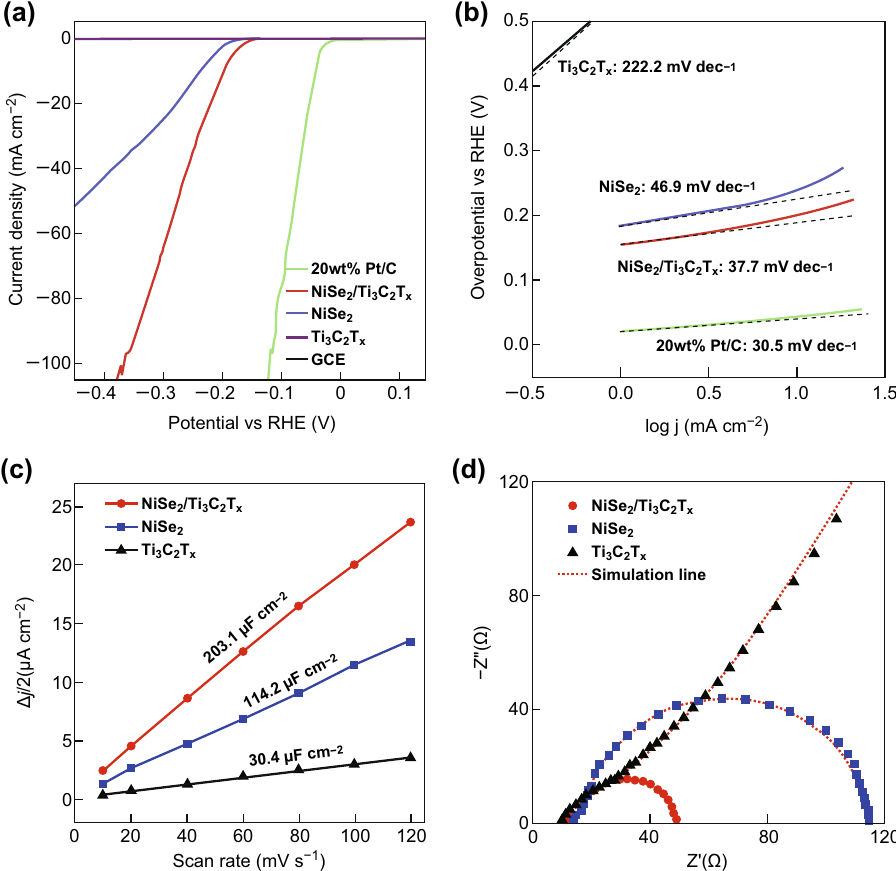
Fig. 4 HER catalytic performance in 0.5 M H 2 SO 4 solution: a LSV curves of unmodified NiSe 2 , NiSe 2 /Ti 3 C 2 T x hybrid, pure Ti 3 C 2 T x , 20 wt%Pt/C, and glassy carbon electrode at the scan rate of 5 mV s −1 . b Tafel plots of unmodified NiSe 2 , NiSe 2 /Ti 3 C 2 T x hybrid, pure Ti 3 C 2 T x , and 20 wt%Pt/C. c The extracted double‑layer capacitances of different electrodes using a cyclic voltammetry method. d EIS Nyquist plots in the range of 10 mHz to 100